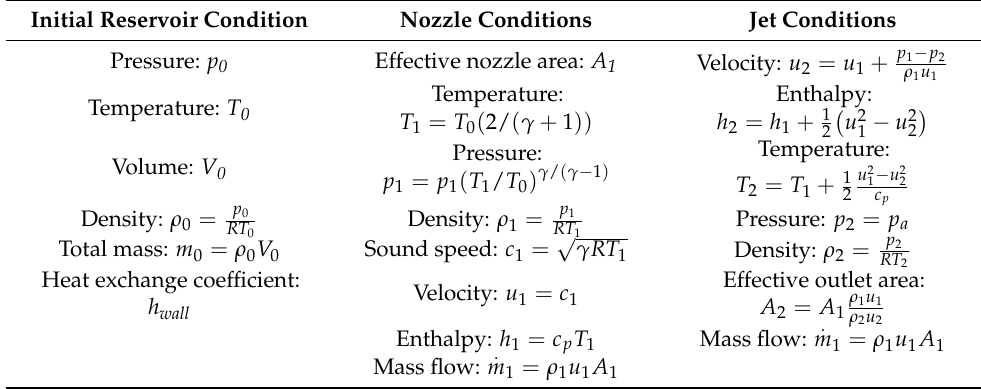
Table 1. Numerical simulation of the jet model for hydrogen leakage from the storage tank. Initial Reservoir